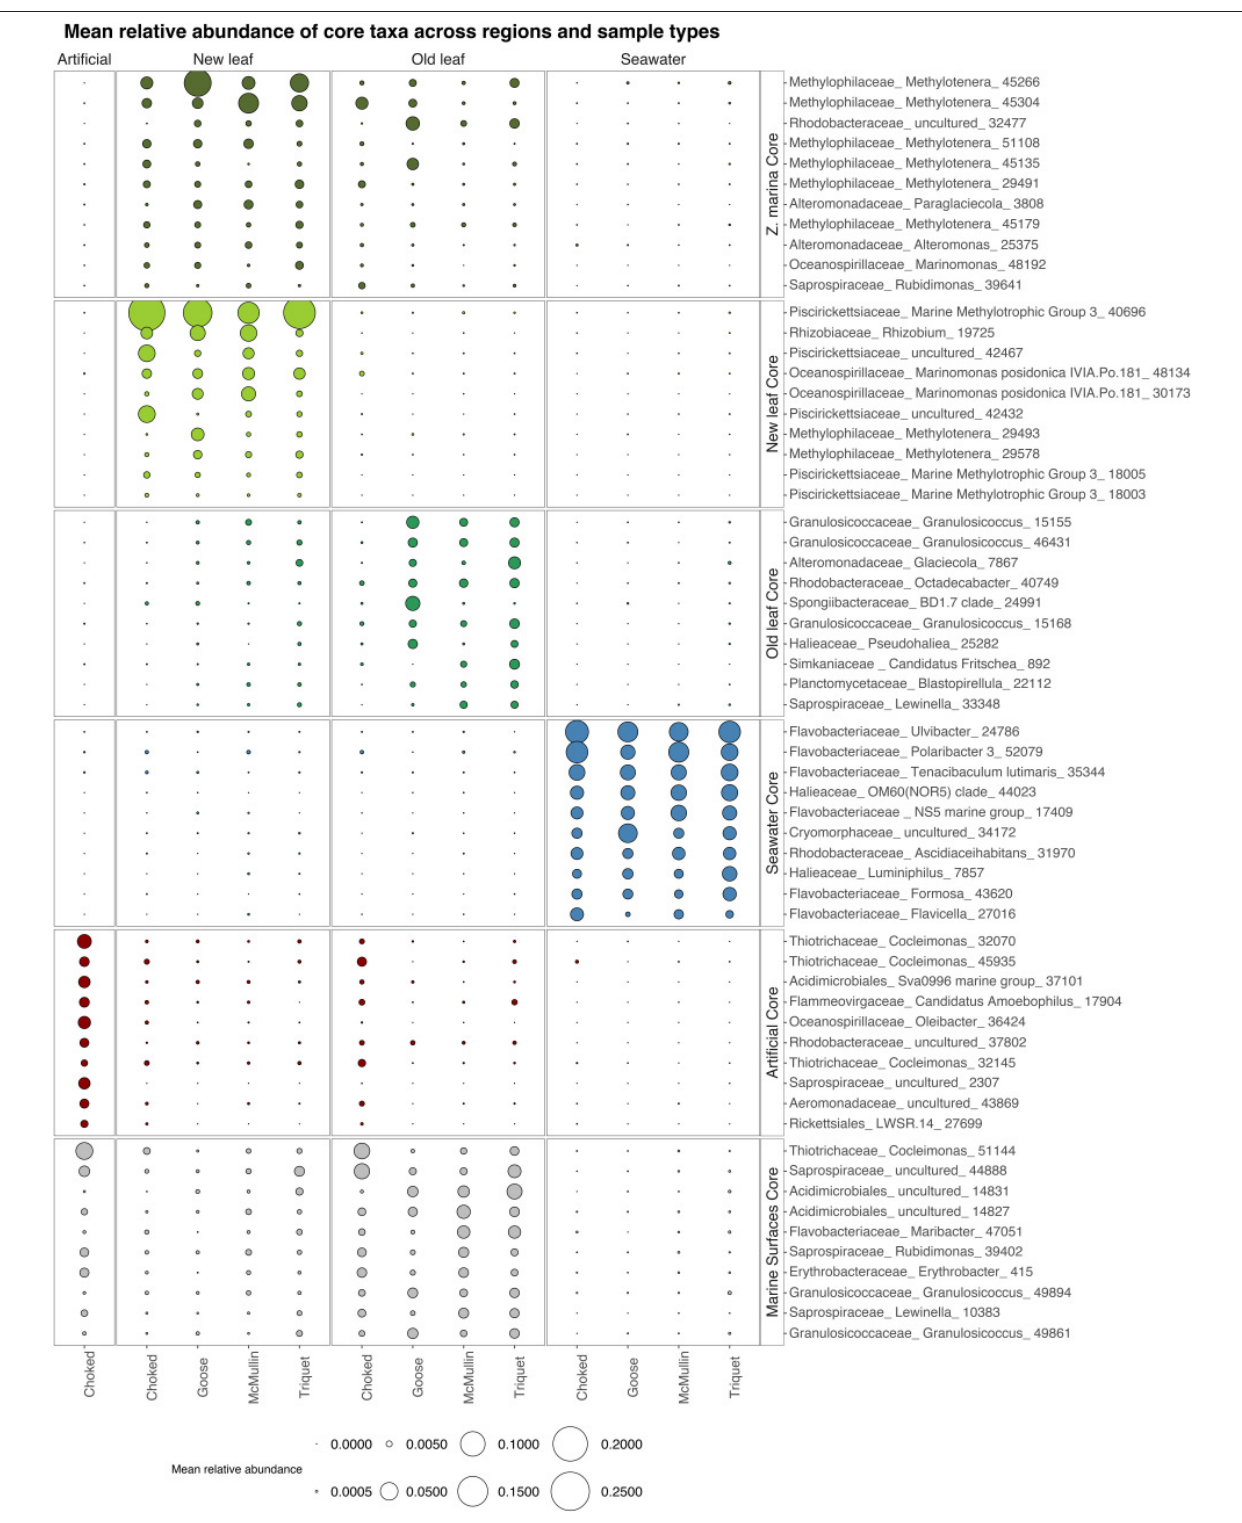
Frontiers in Ecology and Evolution |